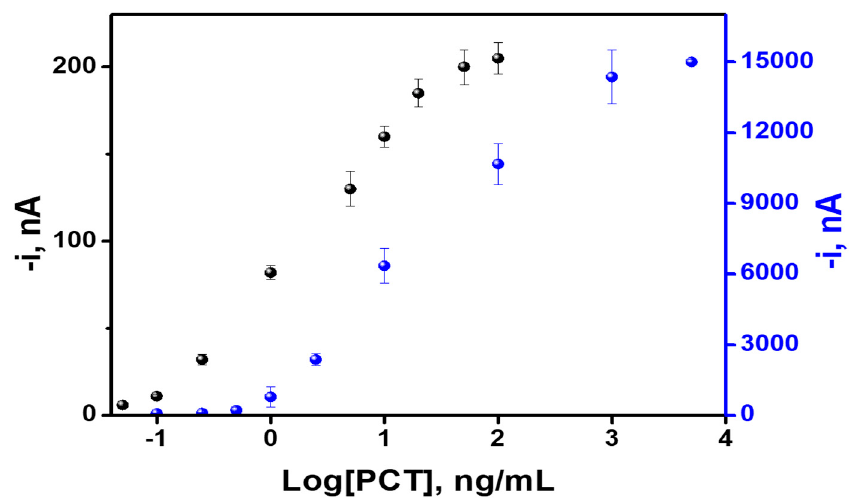
Figure 3. Calibration curves for PCT determination using both approaches: on-drop SPE-C and on-chip EMC-Au. The results are expressed as Mean values ± standard deviation (n = 3). The error bar corresponds with the standard deviation.